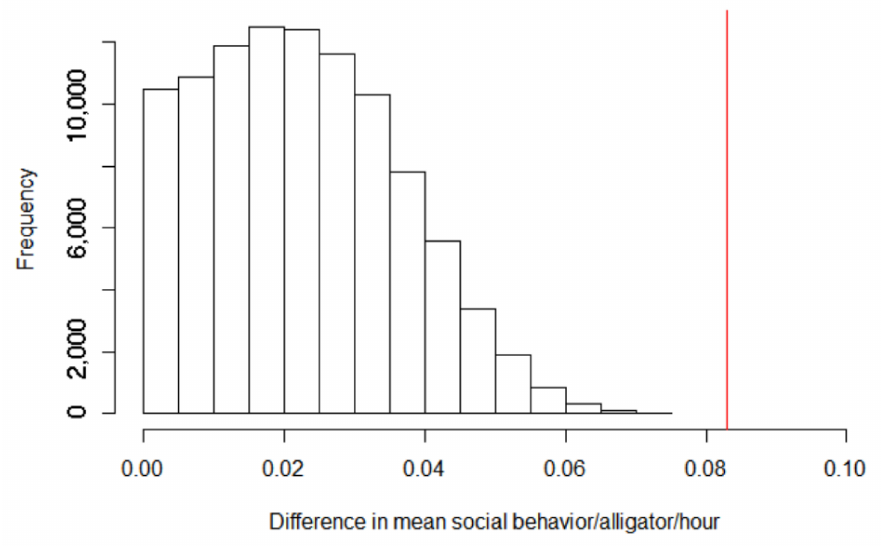
Figure 2. Frequency histogram of the 100,000 permutations of difference in mean social behav- ior/alligator/hour. This parameter was calculated by subtracting the mean number of social